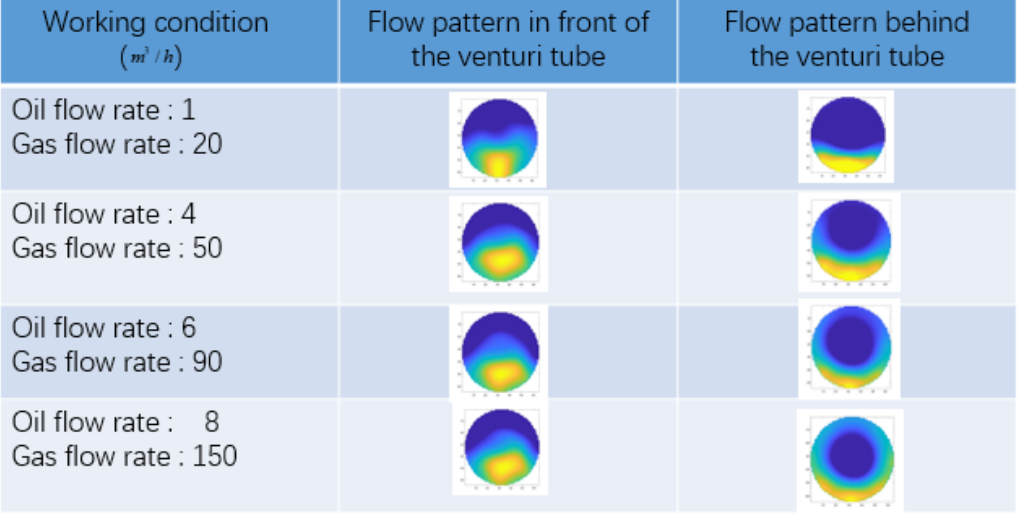
Figure 3. Averaged electrical capacitance tomography (ECT) image (100 frames) of flow distribution before and after venturi tube.